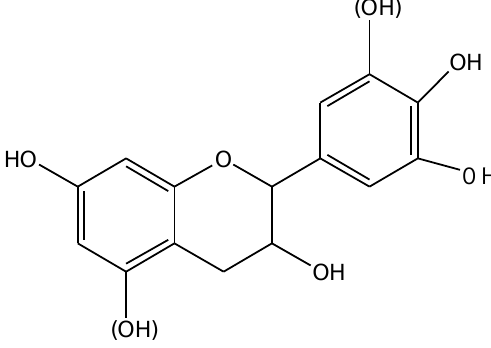
Figure 1. Structure of flavonoid unit of condensed tannins.